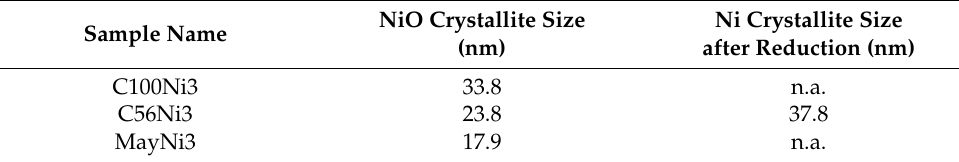
Table 5. NiO and Ni (after TPR) crystallite size of bi-functional